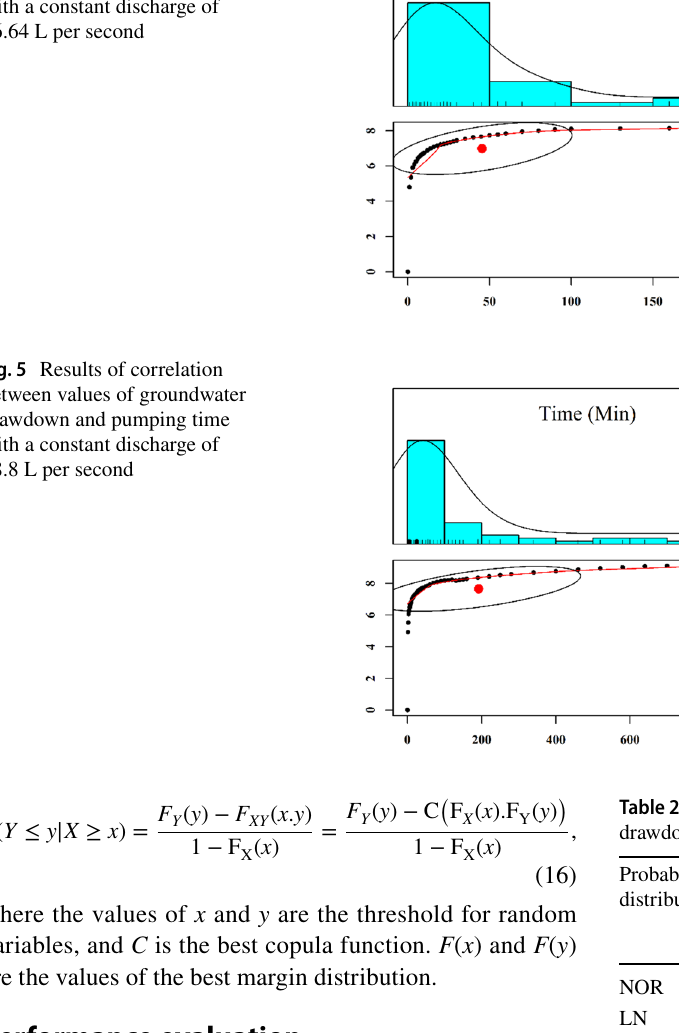
Fig. 4 Results of correlation between values of groundwater drawdown and pumping time with a constant discharge of 26.64 L per second